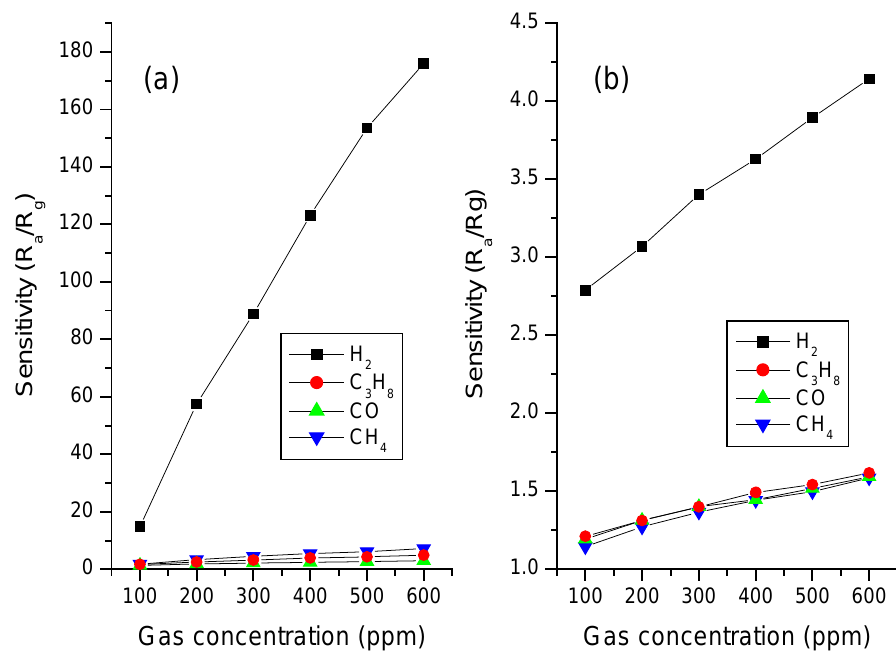
Figure 6. Sensitivity as a function of gas concentration of the (a) SiO sensor and (b) F-doped SnO